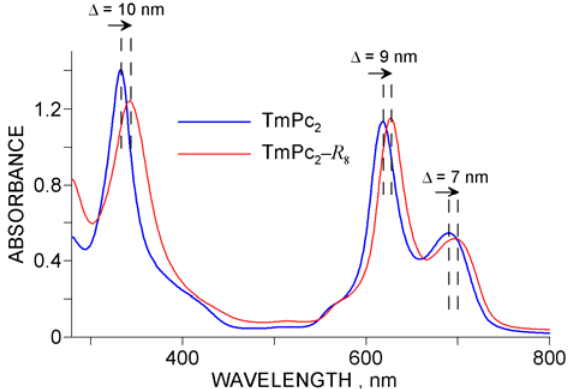
Figure 7. Comparison of UV-Vis spectra of TmPc the effect of pentadecylphenoxy- peripheral substitution of the phthalocyanine macrocycles.